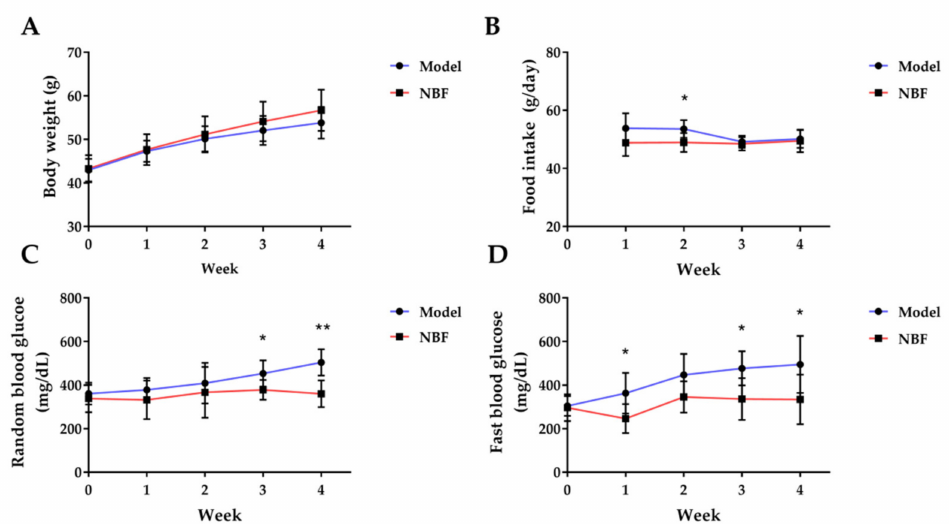
Figure 6. Effects of NBF on body weight, food intake, random blood glucose, and fast blood glucose levels in db/db mice during 4 weeks. ( A ) Body weight changes, ( B ) food intake changes, ( C ) ran- dom blood glucose changes, and ( D ) fast blood glucose changes. Model: diabetic mice untreated; NBF: diabetic mice treated with NBF at a dose of 200 mg/kg body weight. Data are presented as mean ± SD ( n = 6); * p < 0.05, ** p < 0.01 versus model